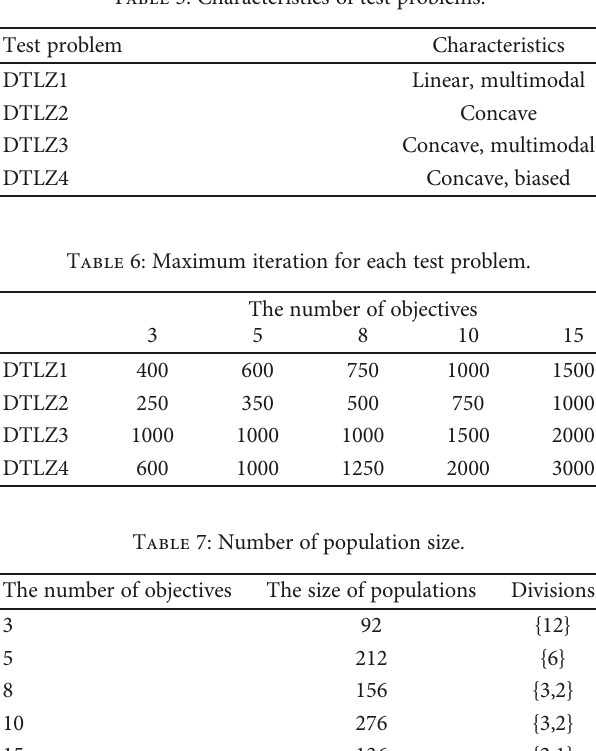
Table 5: Characteristics of test problems.